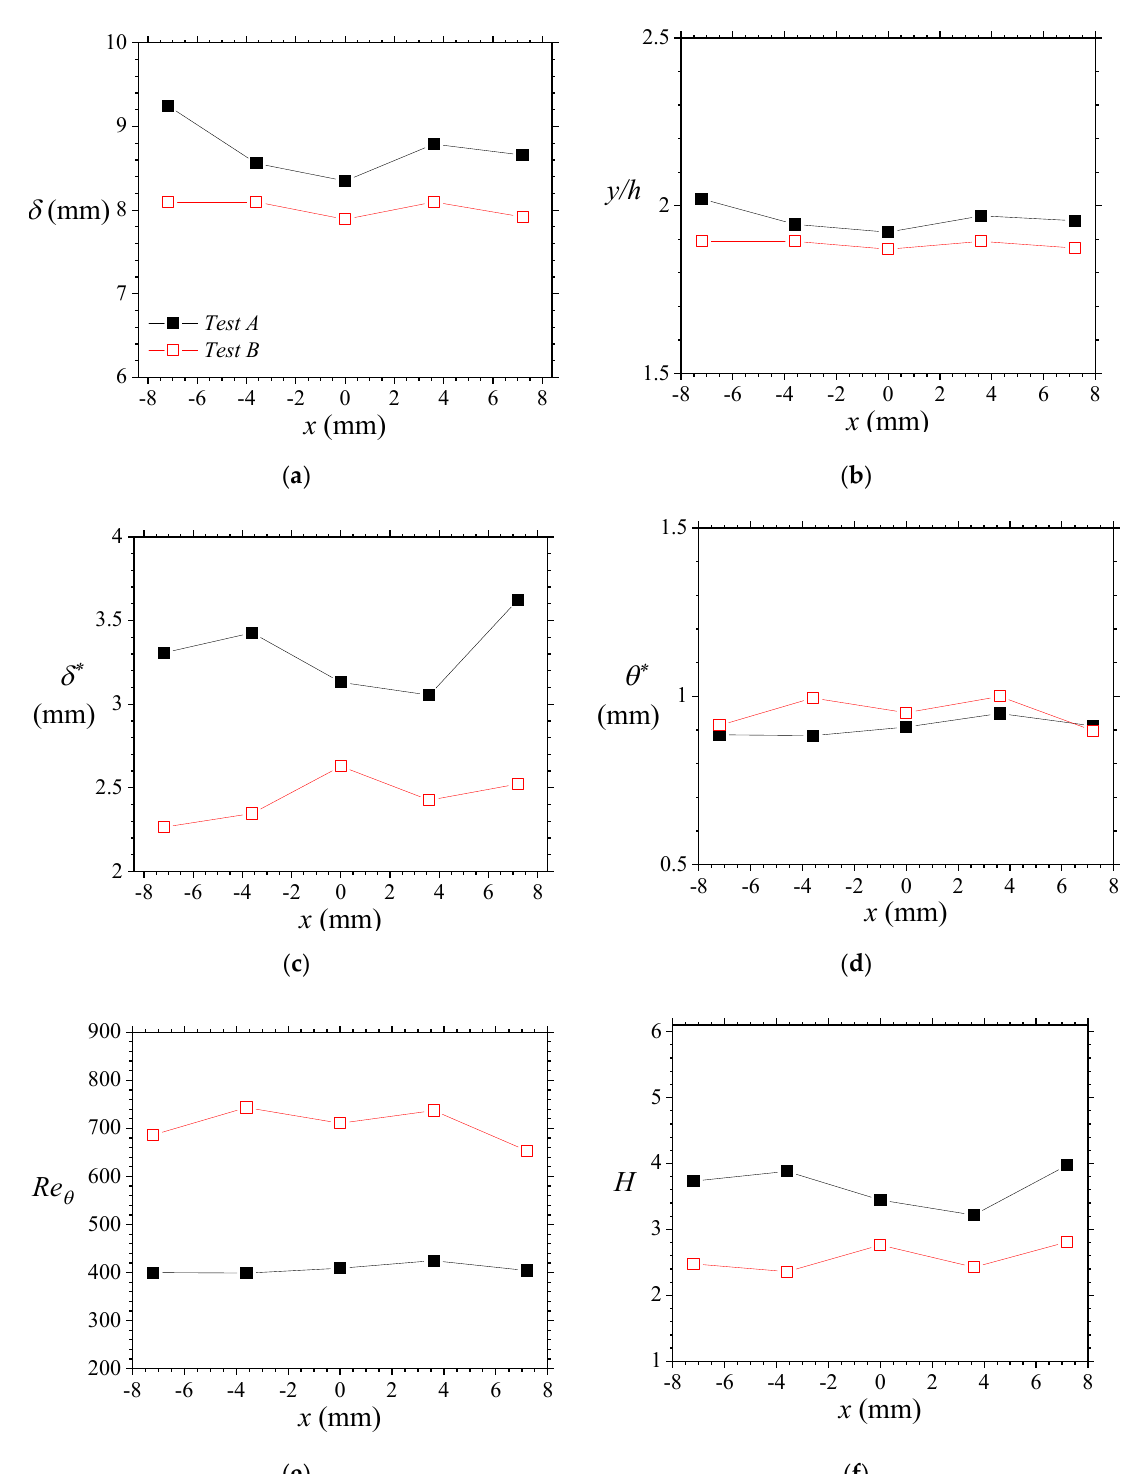
Figure 10. Spanwise variation of ( a ) boundary layer thickness; ( b ) location of the edge of the boundary layer ( y / h values at 0.99< U max > ); ( c ) displacement thickness; ( d ) momentum thickness; ( e ) Reynolds number based on momentum thickness and maximum velocity; and ( f ) shape parameter. Note that the legend showed in ( a ) applies to ( b – f ).